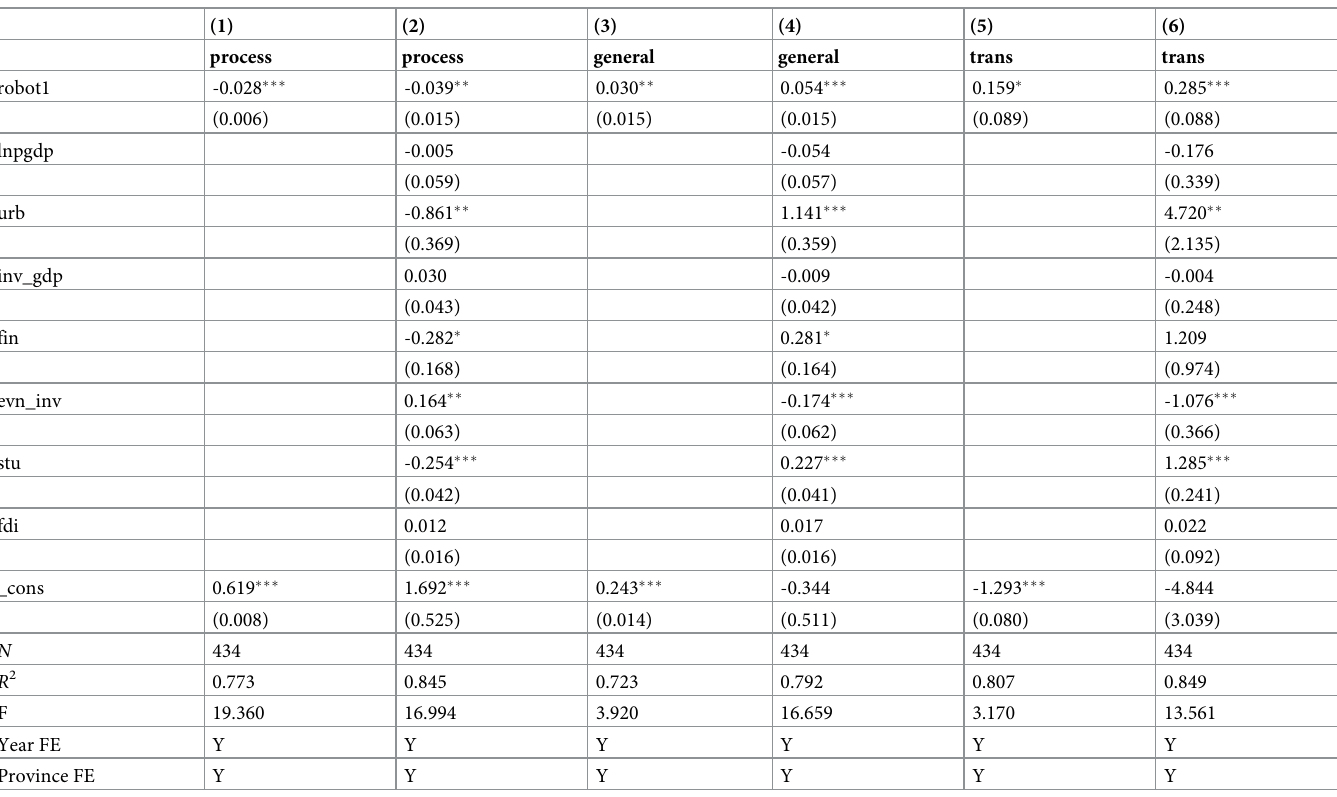
Table 2. Benchmark regression